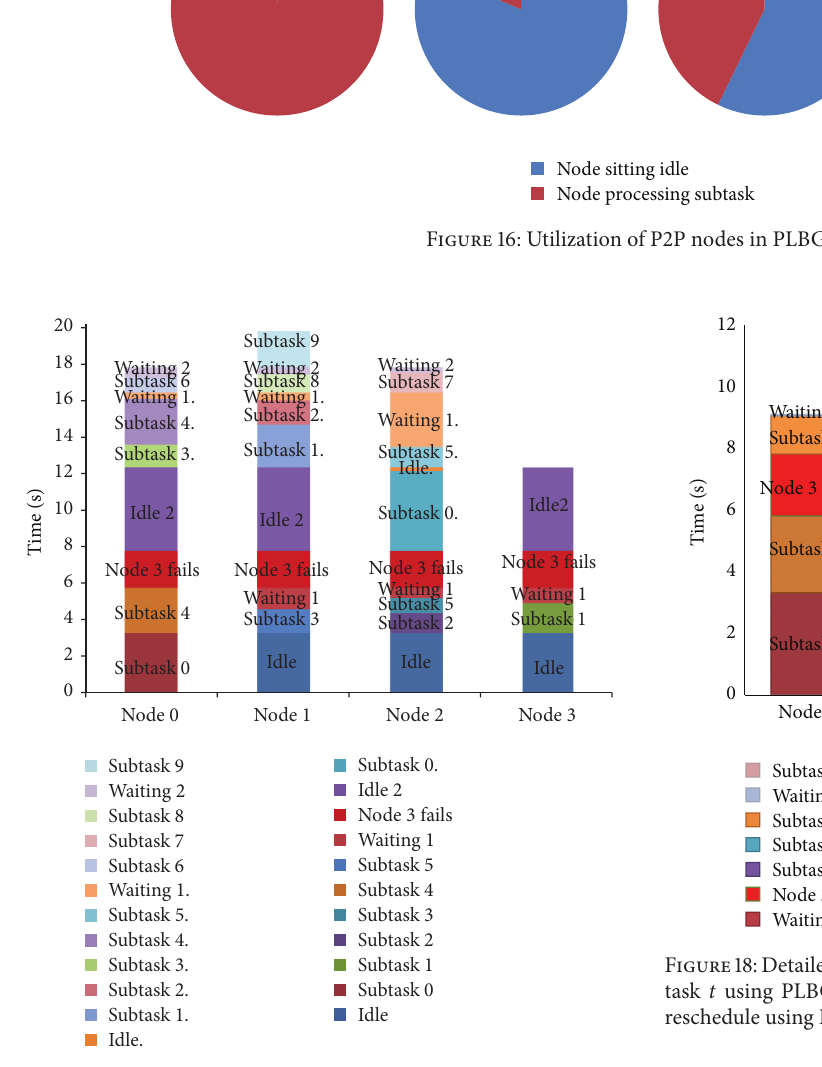
Figure 17: Detailed time wise schedule for all subtasks of DAG based task t using old GA when N 3 fails at level 3 of task t . Here we reschedule using old GA.